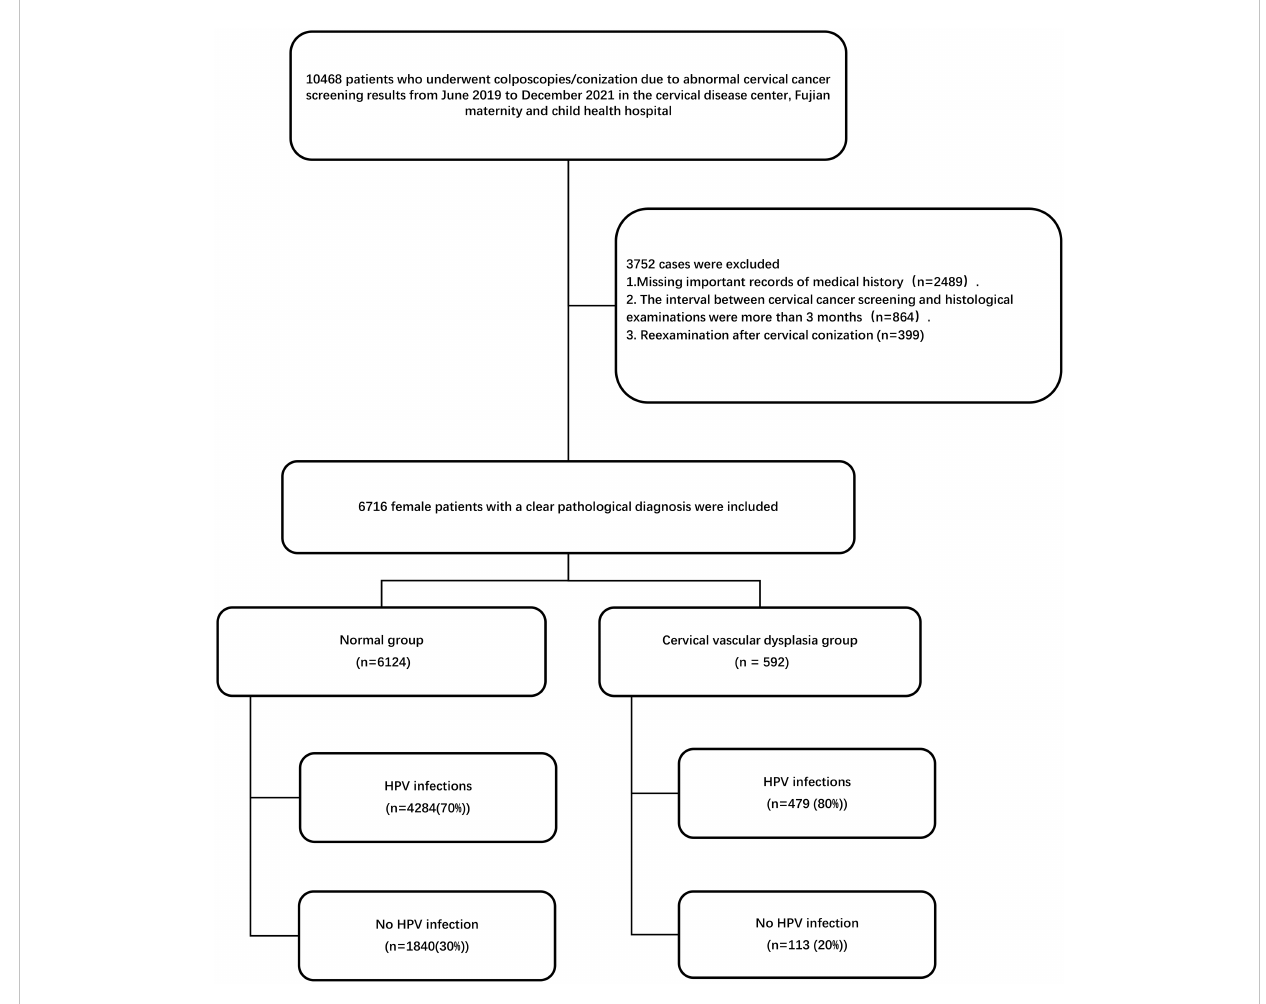
FIGURE 1 Study design. HPV, human